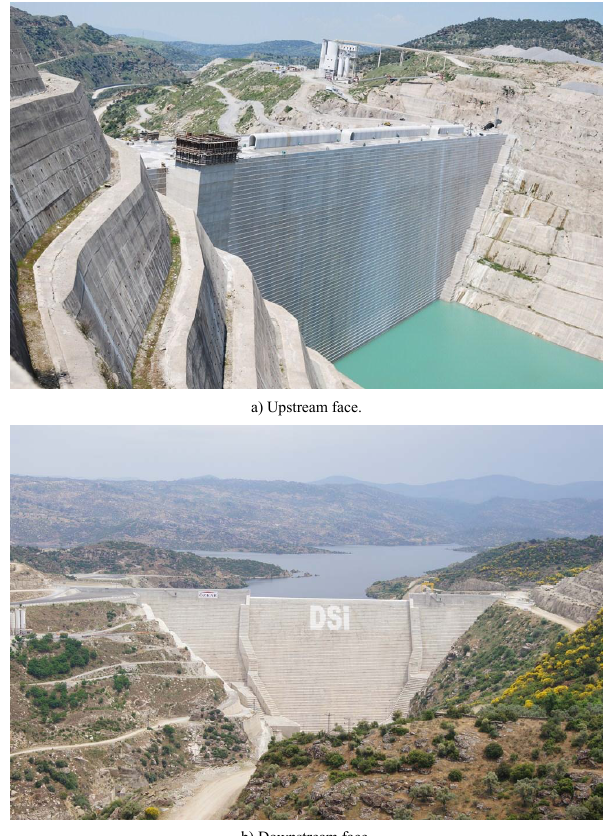
Fig. 7. The view of the Çine RCC dam (DSI, 2012).